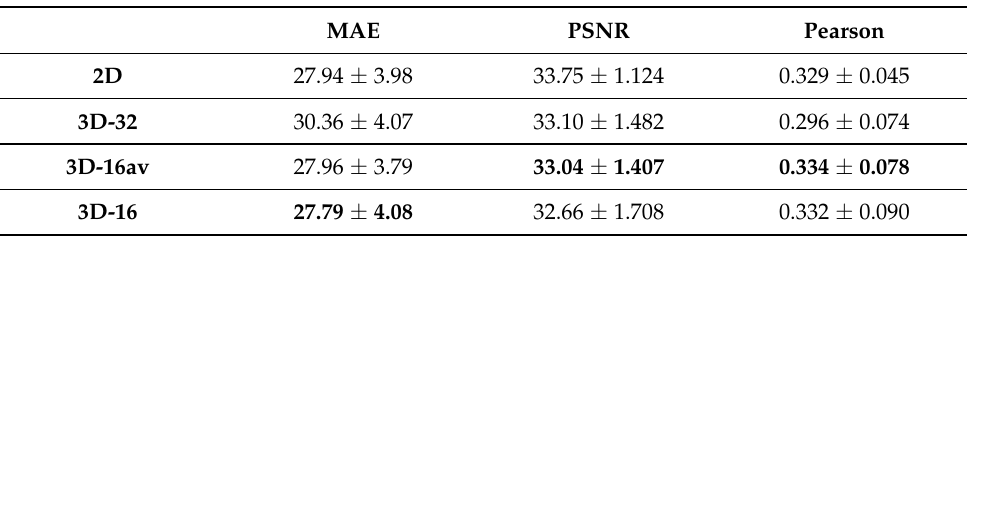
Table 11. Head dataset Soft-tissue with Atrous-Net. Mean Absolute Error, PSNR and Pearson coefficient within the soft-tissue on the head data set obtained using Atrous net with different convolutions and